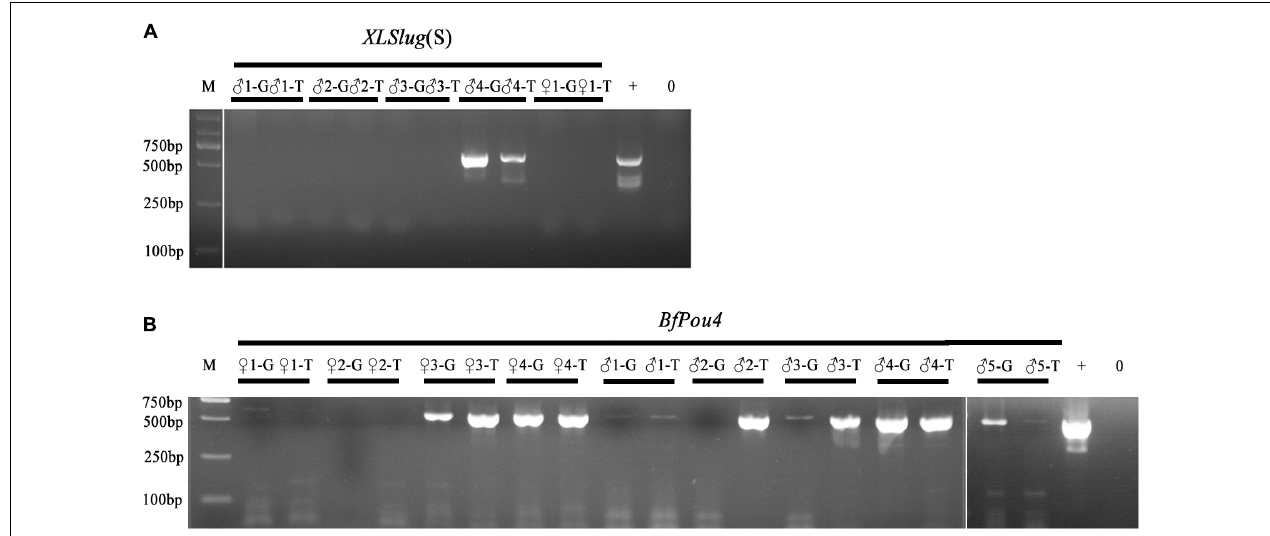
FIGURE 3 | Detection of transgene in tail tips and gametes of F0 animals. (A) Analysis of F0 animals injected with XLSlug (S)- mCherry construct. (B) Analysis of F0 animals injected with BfPou4 - mCherry construct. The presence of the 624 bp band indicates successful insertion of target sequence. + means positive control and − means negative